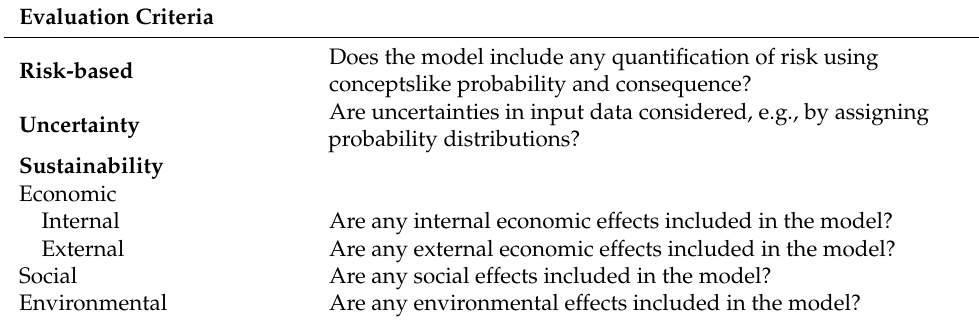
Table 2. Evaluation criteria based on the presented